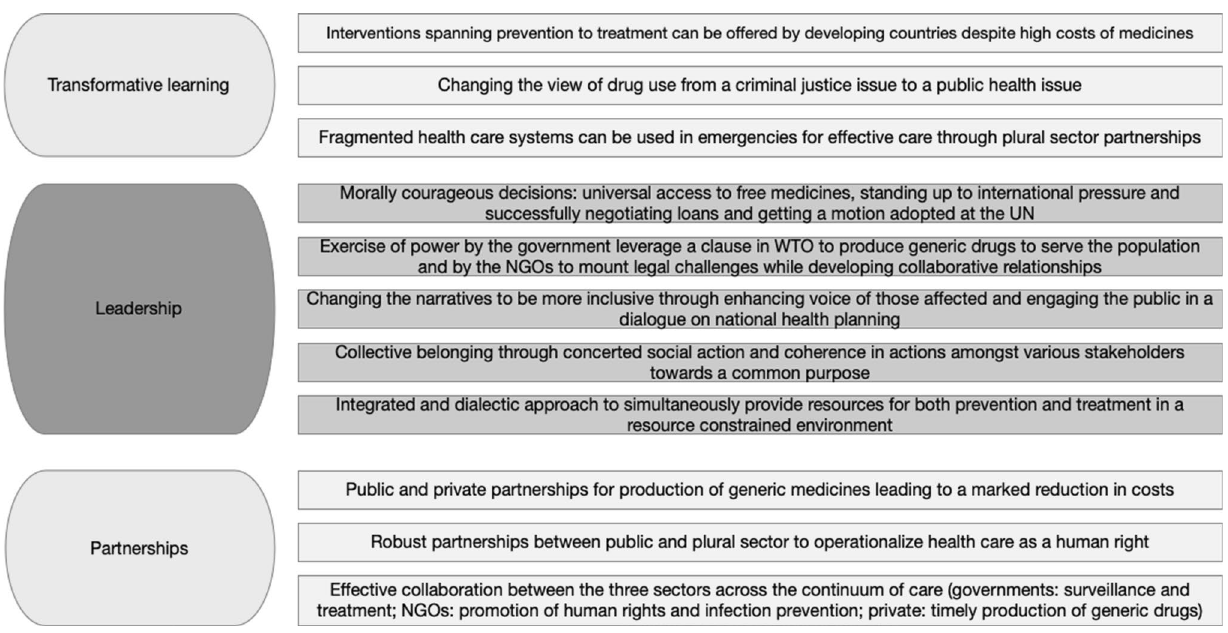
Fig. 2 Themes in Brazil’s successful response to HIV crisis (extracted from references quoted in the text). The figure was made using Omni- graffle software and exported to TIFF